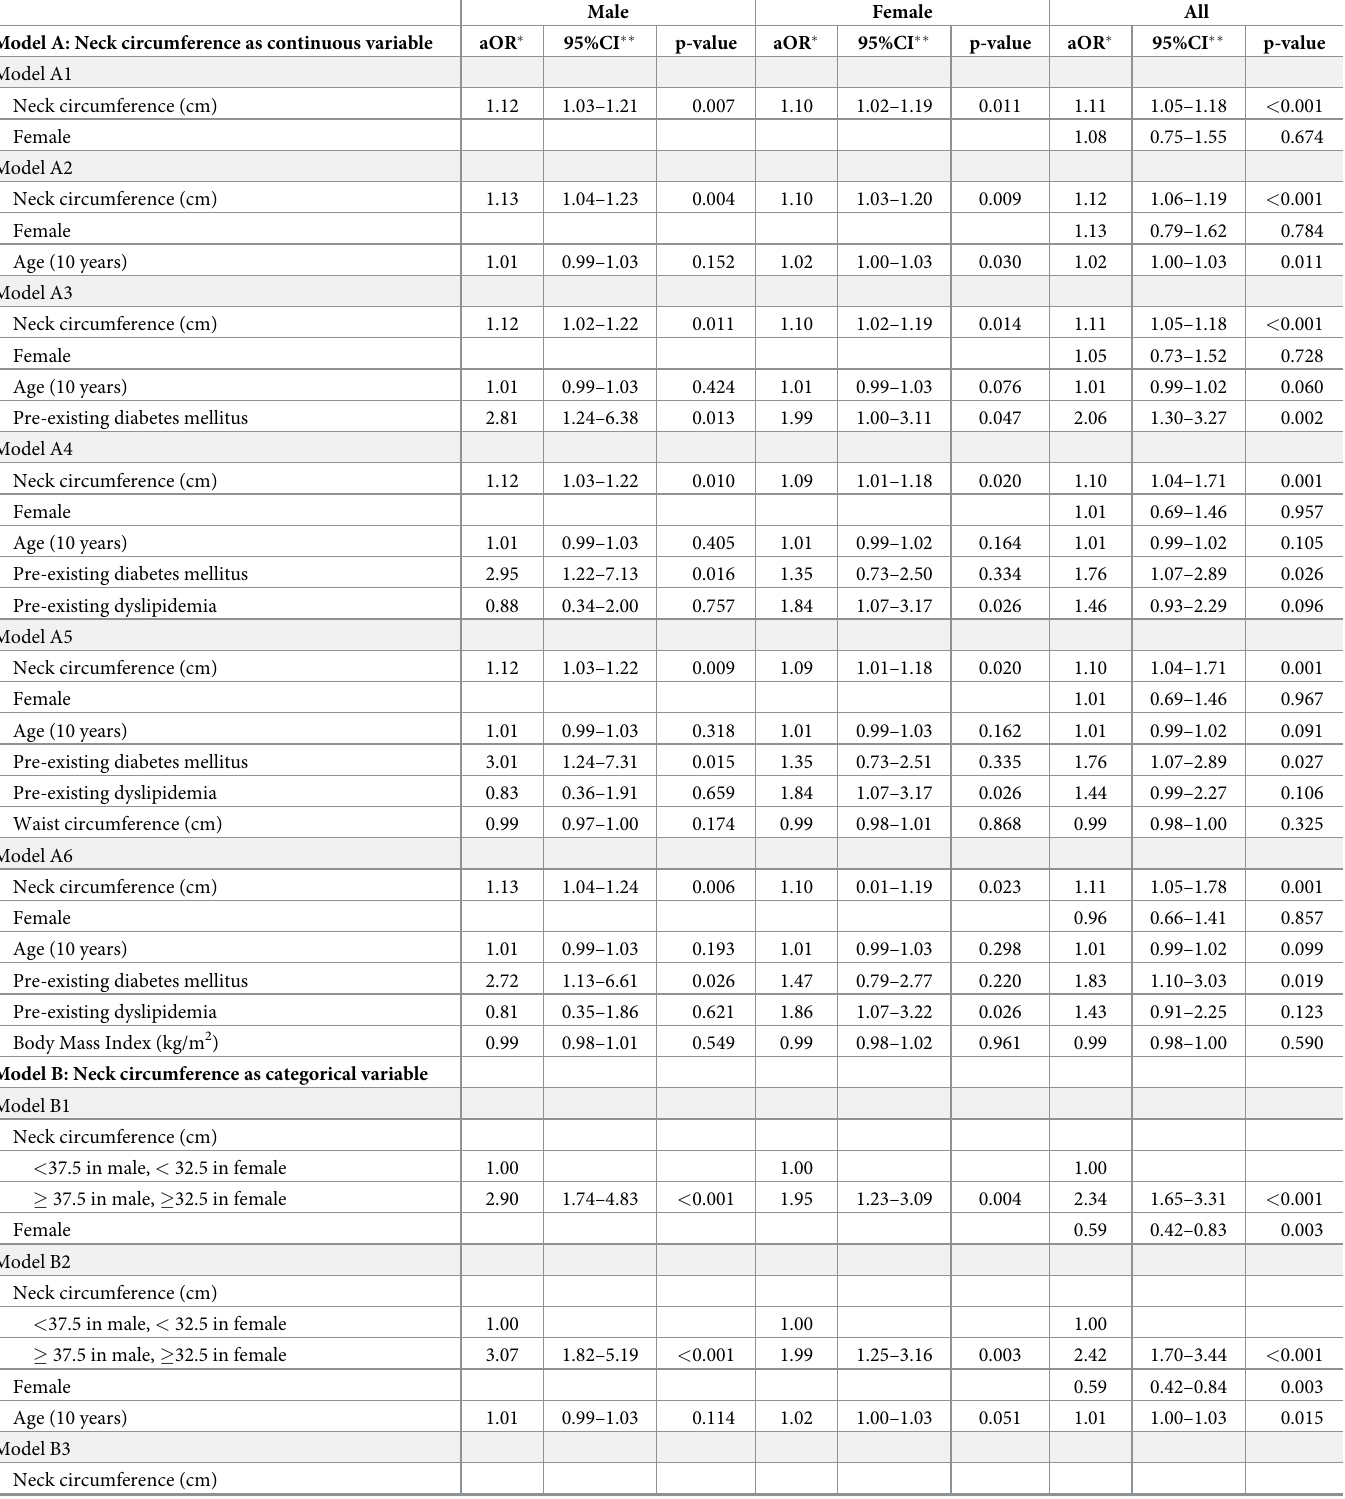
Table 3. Multivariate logistic regression analysis to assess relationships between associated risk factor and hypertension stratify by gender (male, female and